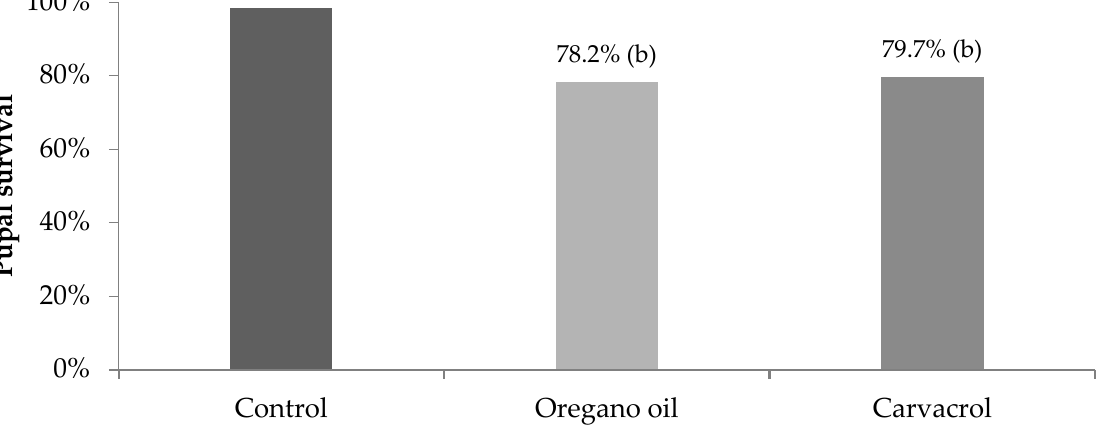
Figure 2. Pupal survival (%) of Cx. pipiens biotype molestus mosquitoes that remained alive after 24 h exposure of 3rd–4th instar larvae to LC 50 concentrations of oregano oil ( n = 55) and carvacrol ( n = 69), and to water solution of 2% DMSO (control) ( n = 71). Percentages in a column followed by a different le tt er are signi fi cantly di ff erent ( p < 0.05).